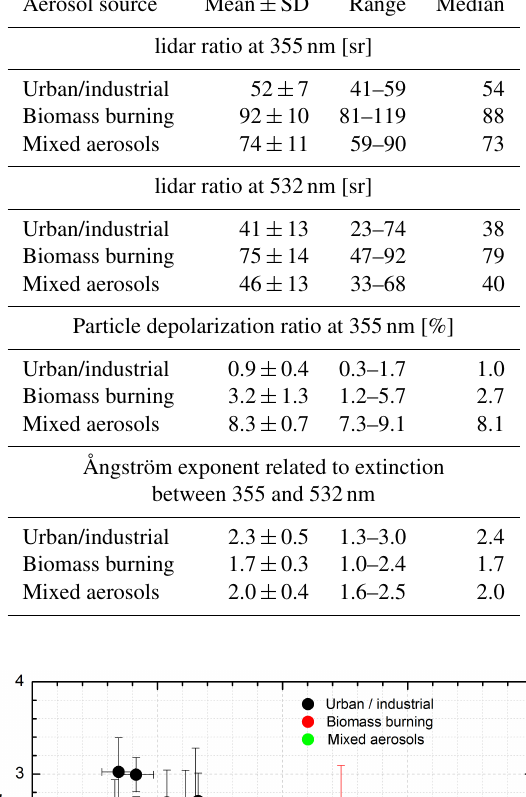
Table 2. Mean value ± standard deviation of aerosol lidar ratio at 355, particle depolarization ratio and Ångström exponent related to extinction between 355 and 532nm for the examined aerosol types, as well as value of range and median.